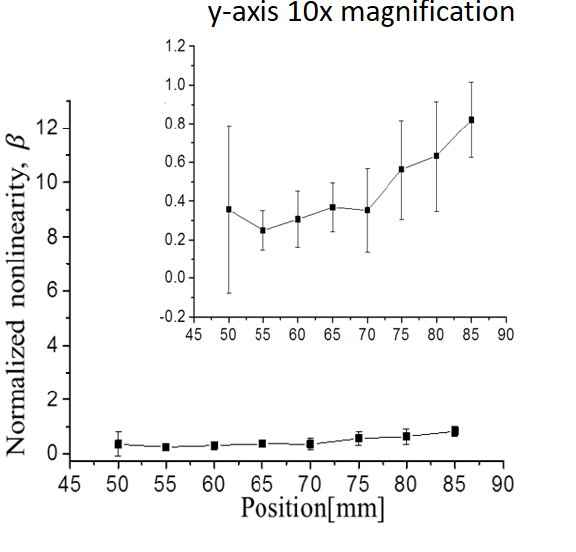
Table 5. Experimental conditions for guided wave mixing technique.